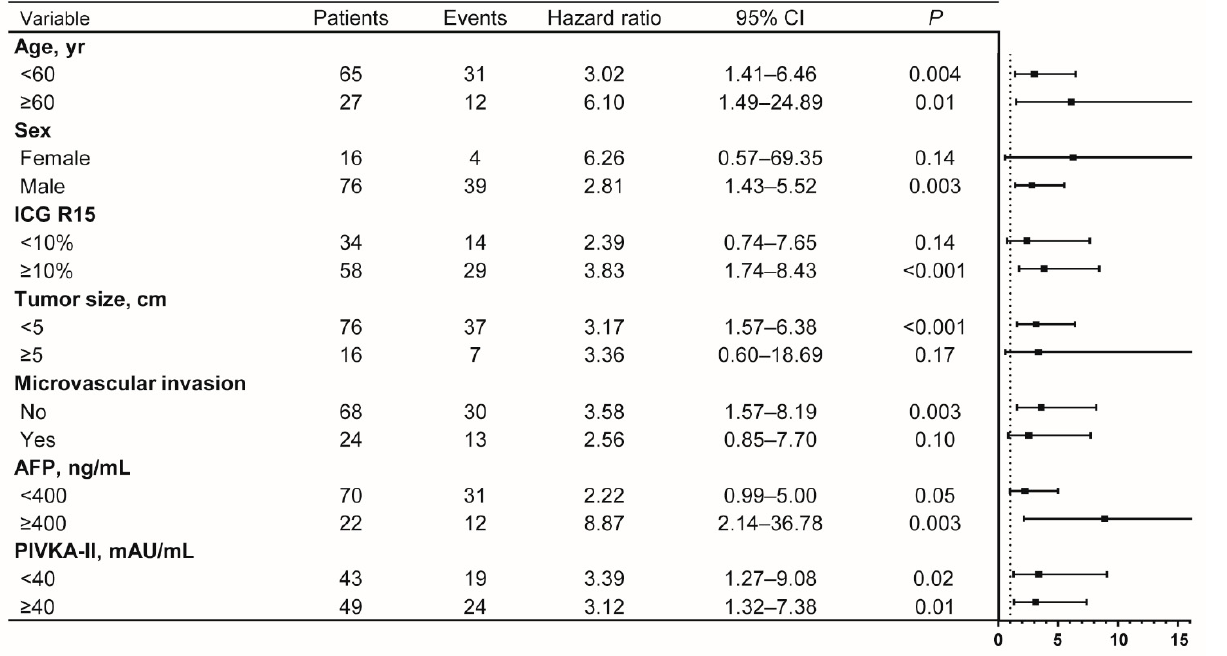
In the multivariable regression analysis, high serum α -fetoprotein (AFP) levels ( ≥ 400 ng/mL; hazard ratio (HR), 2.08; 95% confidence interval (CI, 1.04–4.17; p = 0.04) and as independent prognostic factors for RFS (Table 2 and Supplementary Figure S2). When subgroup analyses were conducted, patients with high baseline SORD levels had worse RFS across all subgroups compared with low baseline SORD levels (Figure 3).